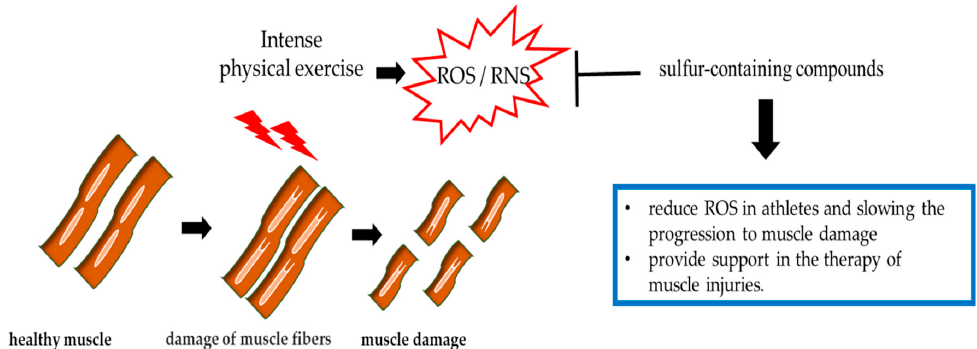
ff ects of exercise-induced ROS / RNS on muscle Figure 5. The effects of exercise-induced ROS/RNS on muscle damage. Figure 5. The e